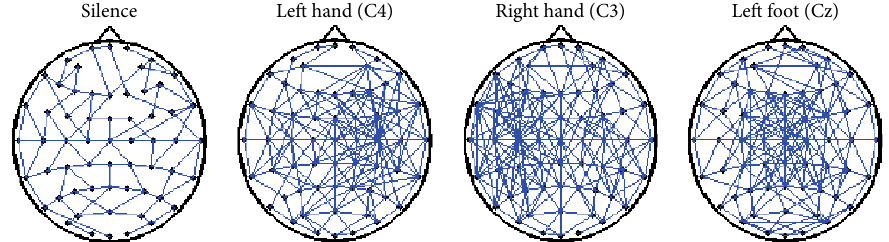
Figure 1: BFN topological structures of simple limb MI. Note: Contents in parentheses represent the regions with the highest degree of aggregation corresponding to the current MI.